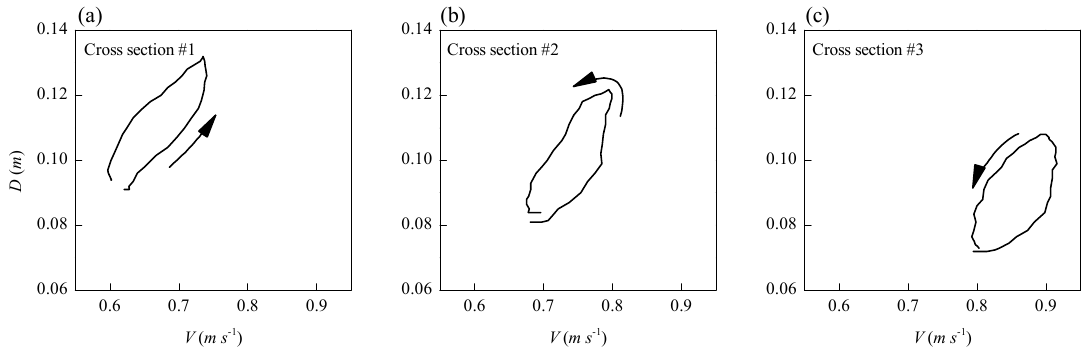
Figure 3. The flow depth hydrographs of the No. 1-1 flood event.